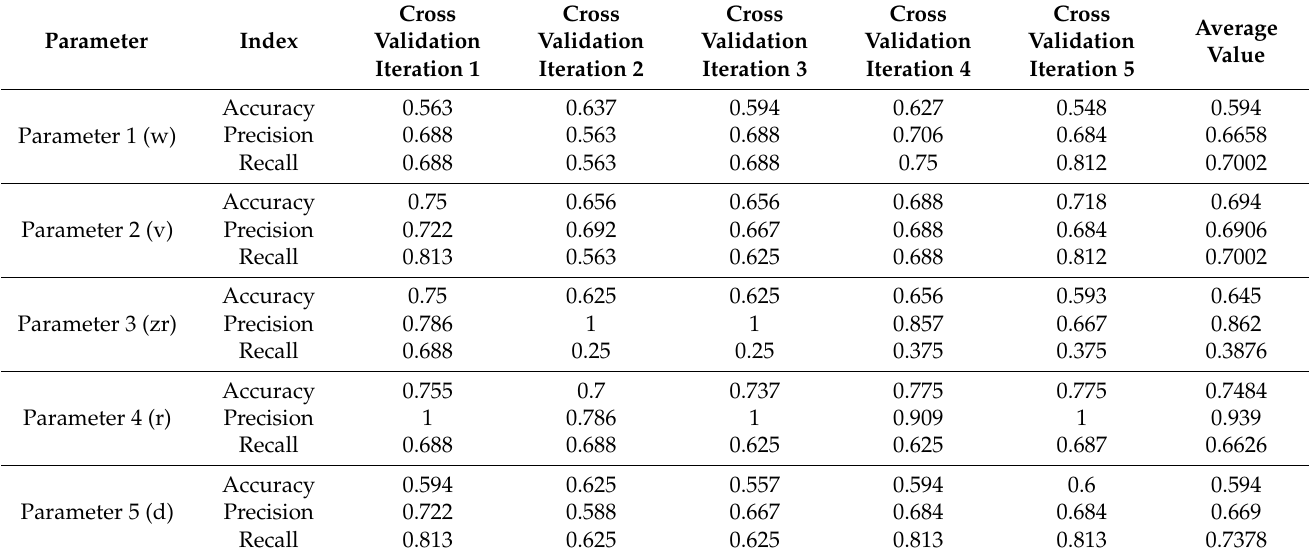
Table 6. Index of classification of human falls and object